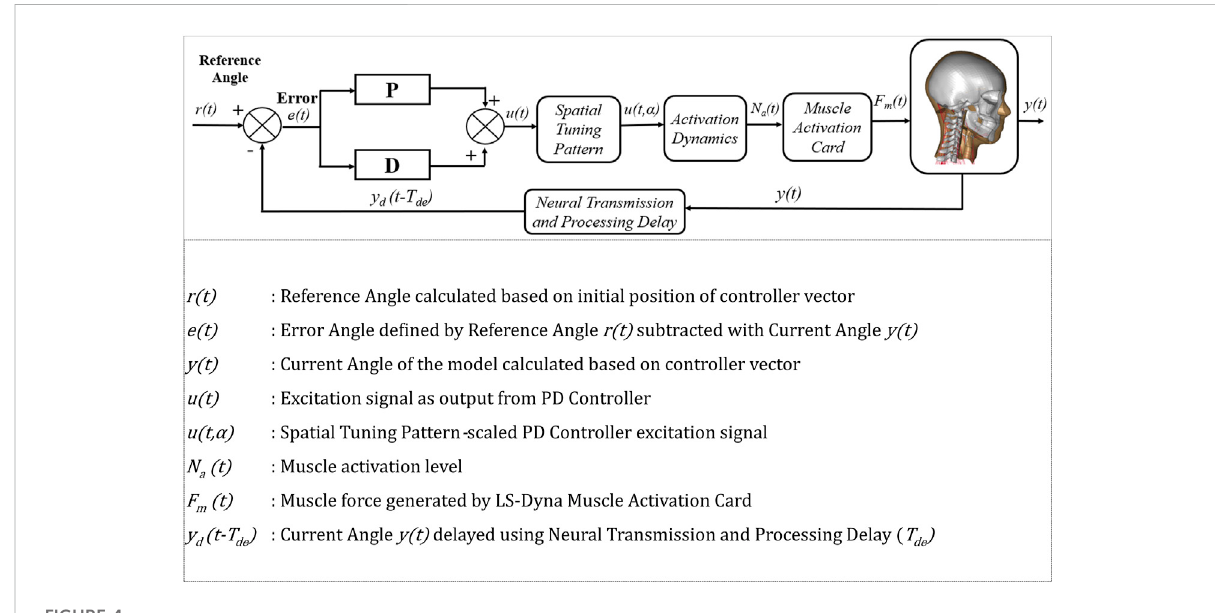
FIGURE 4 APF PD controler